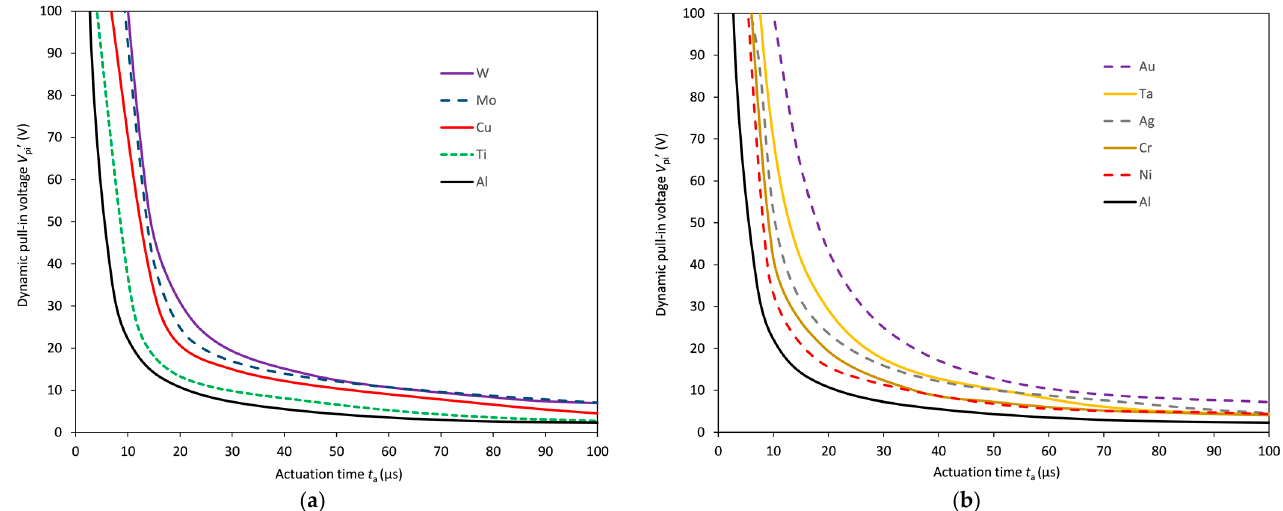
Figure 16. Relationships between dynamic pull-in voltage and actuation time of MEMS cantilevers made of ( a ) W, Cu, Ti, Mo and Al ( b )Au, Cr, Ta, Ag, Ni and Al, Al appears as a reference in both sub-figures.